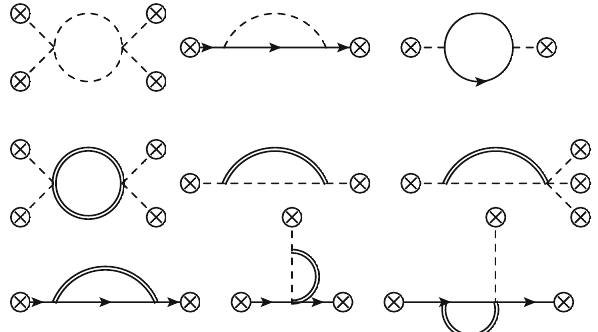
Fig. 2 Various diagrams containing divergences with two vertices. Here the dashed line represents the scalar field, the solid line with arrow represents fermion field, while the double line represents the h μν -field. Here the graphs on the first line are purely matter ones. The second and third line contain graphs having quantum gravity